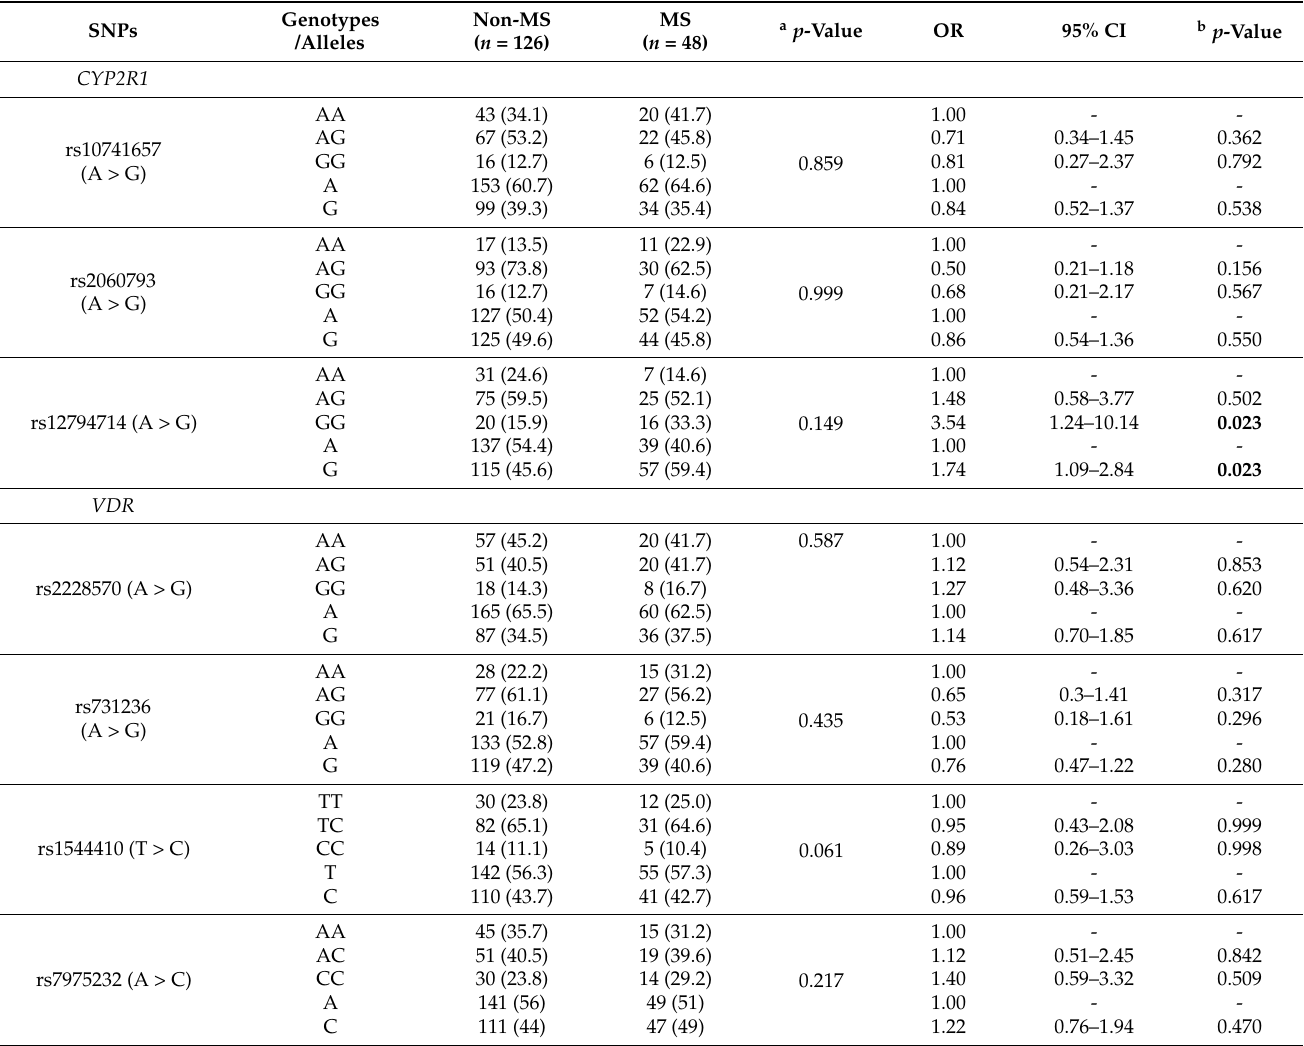
Table 2. Genotype and allele frequencies of the CYP2R1 and VDR polymorphisms in the adolescents in the non-MS and MS